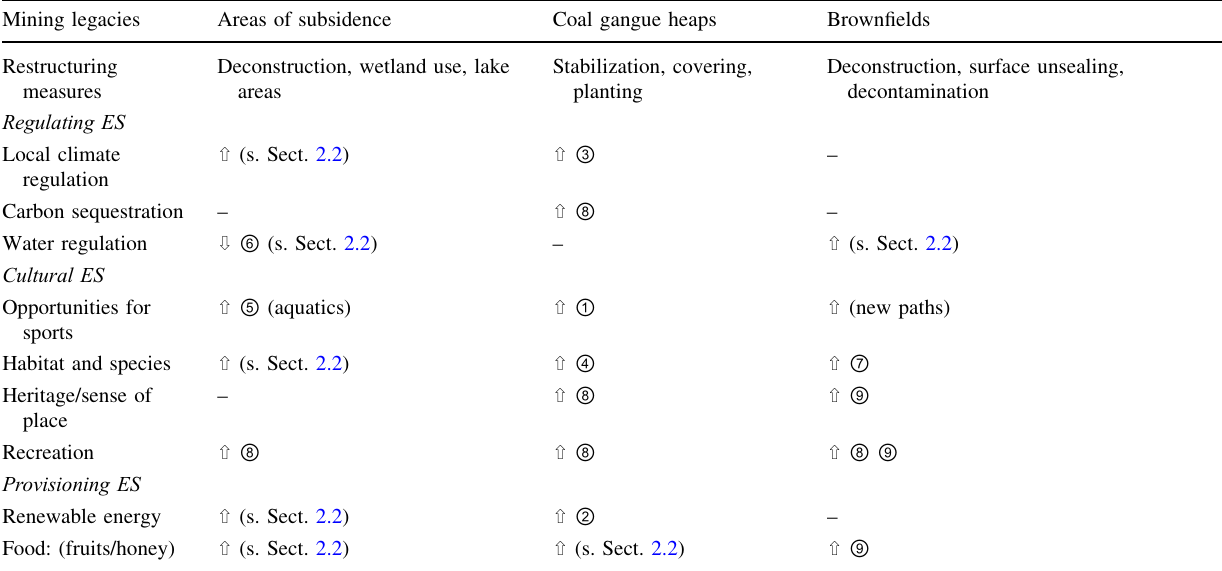
Table 1 Changes to ecosystem services when transforming mining legacies into green spaces (case of Zwickau–Lugau–Oelsnitz) Mining